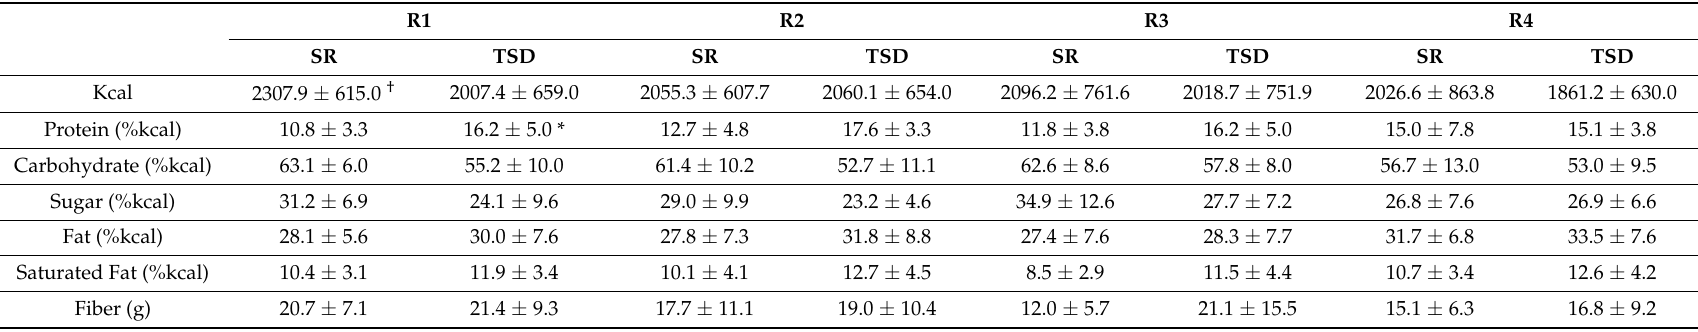
Table 3. Mean ± SD intake for each of the four days following recovery sleep (12 h TIB from 22:00–10:00, R1–R4, N = 24) from sleep restriction (SR; N = 12) or total sleep deprivation (TSD: N =